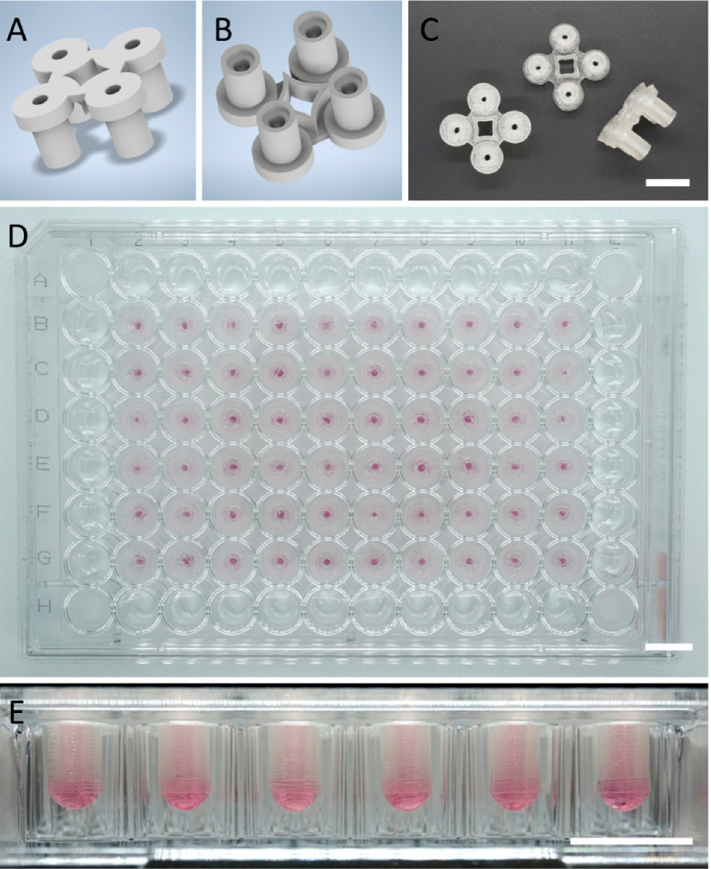
Figure 2. Design and application of Q-serts for 96-well plates. ( A ) Rendered top view of a Q-sert. ( B ) Rendered bottom view of a Q-sert. ( C ) Photographs of the top, bottom, side of Q-serts. ( D ) Fully loaded 96-well plate. ( E ) Drop formation. Scale bars C–E 10 mm.